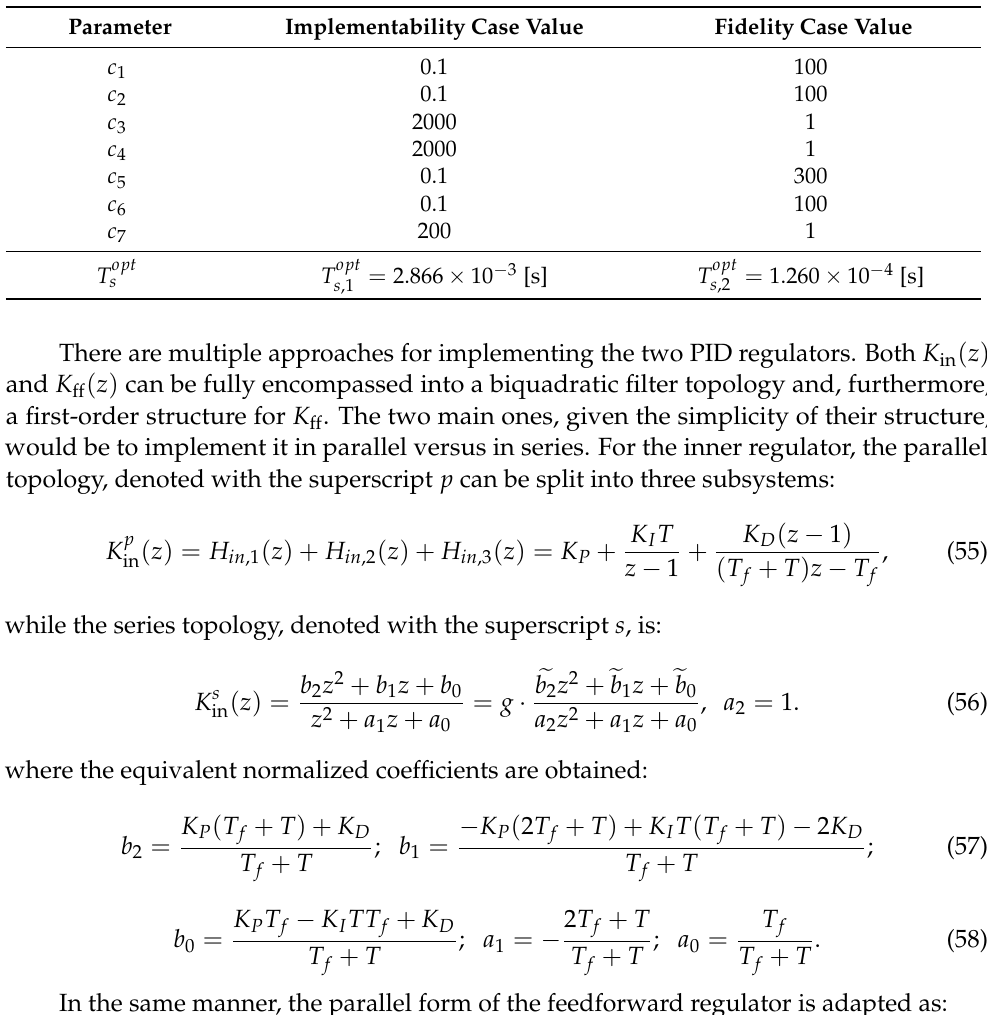
Table 7. Functional weighting coefficients for the two considered experiments of the DC motor case study: main focus on implementability of the resulting controller versus the focus on fidelity compared to the continuous-time control